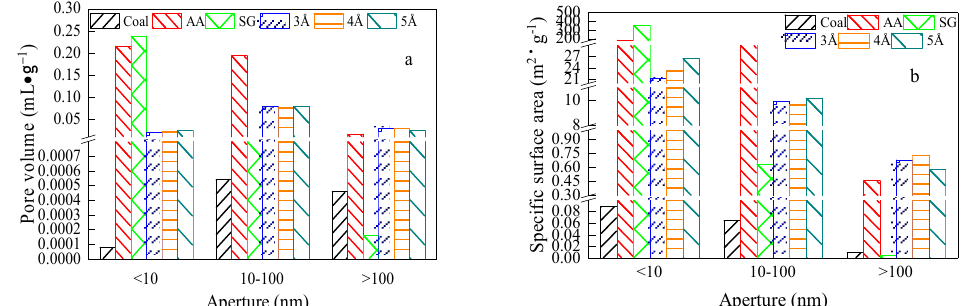
Figure 2. Distribution of pore volume and specific surface area of test materials: ( a ) Pore volume distribution of test materials; ( b ) Specific surface area distribution of test materials.